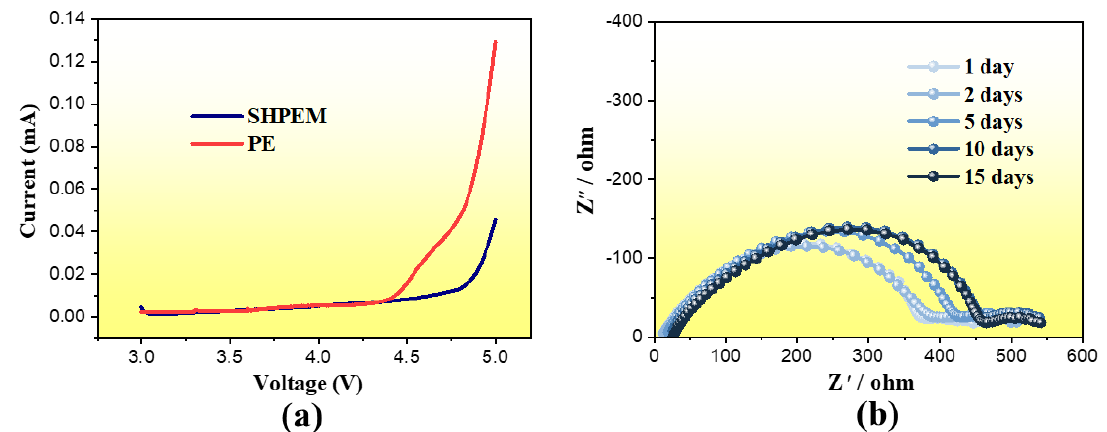
Figure 5. ( a ) Linear-voltammograms on stainless steel for SHPEM and commercial PE at scan rate of 5 mV · s − 1 . ( b ) Impedance spectra of cell Li/SHPEM/Li at open circuit potential.